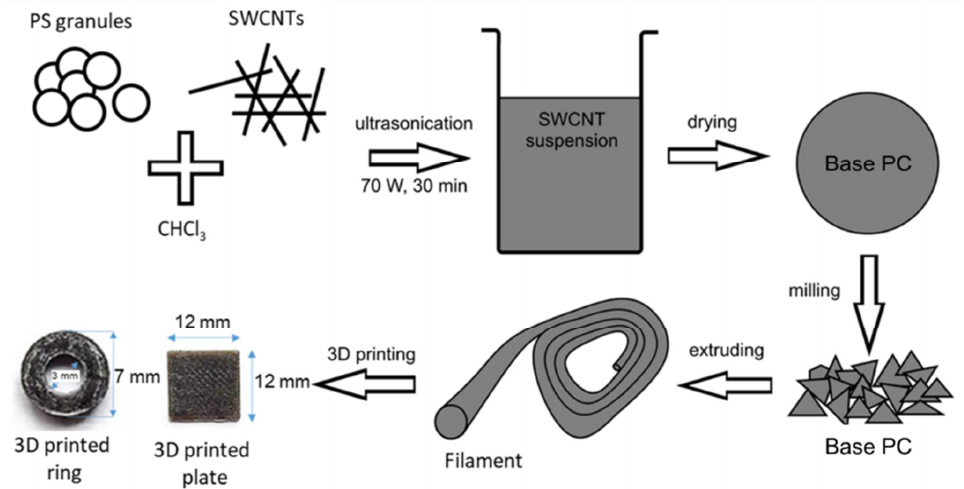
Figure 1. Scheme of the preparation of base composite materials, filaments, and 3D-printed samples from PS and SWCNTs.